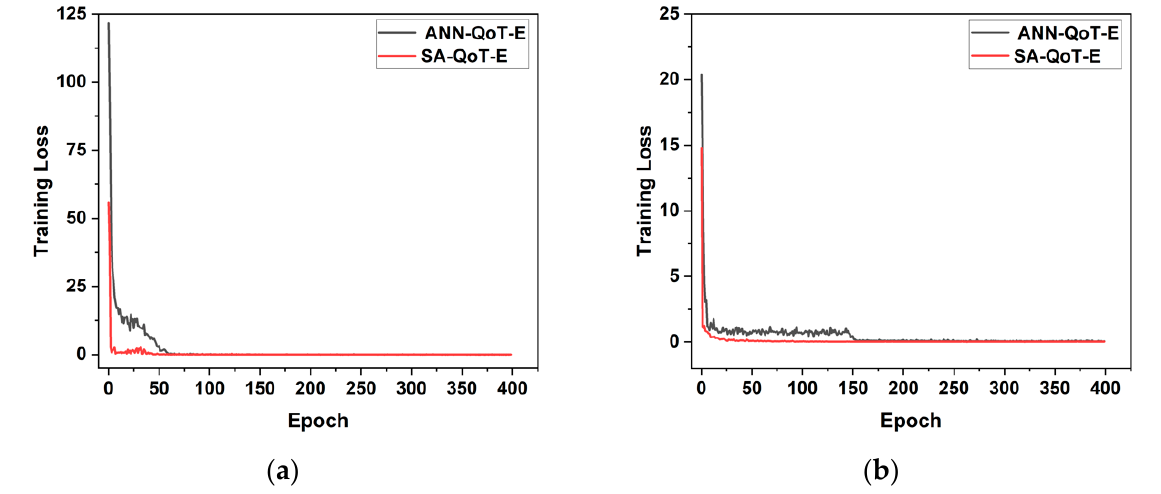
Figure 4. ( a ) Training loss vs. the number of epochs for the ANN-QoT-E and the SA-QoT-E in the Jnet; ( b ) training loss vs. the number of epochs for the ANN-QoT-E and the SA-QoT-E in the NSFnet.